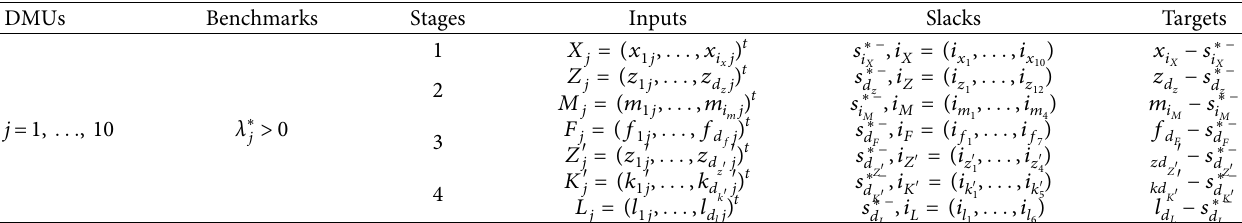
Table 2: Benchmark selection for inefficient DMUs and target setting through the optimal slacks.